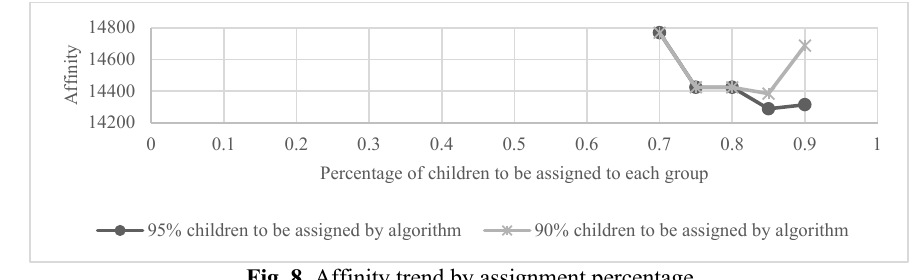
Fig. 8. Affinity trend by assignment percentage